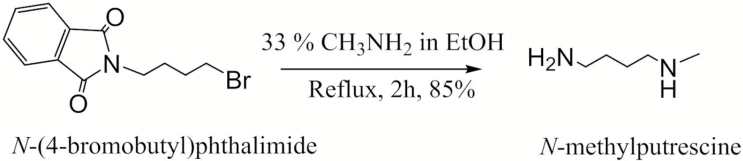
Chemical synthesis of N-methylputrescine.